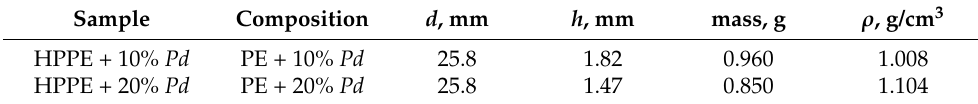
Table 2. The sizes and masses of the tablets were produced by the hot-pressed method. Sample Composition